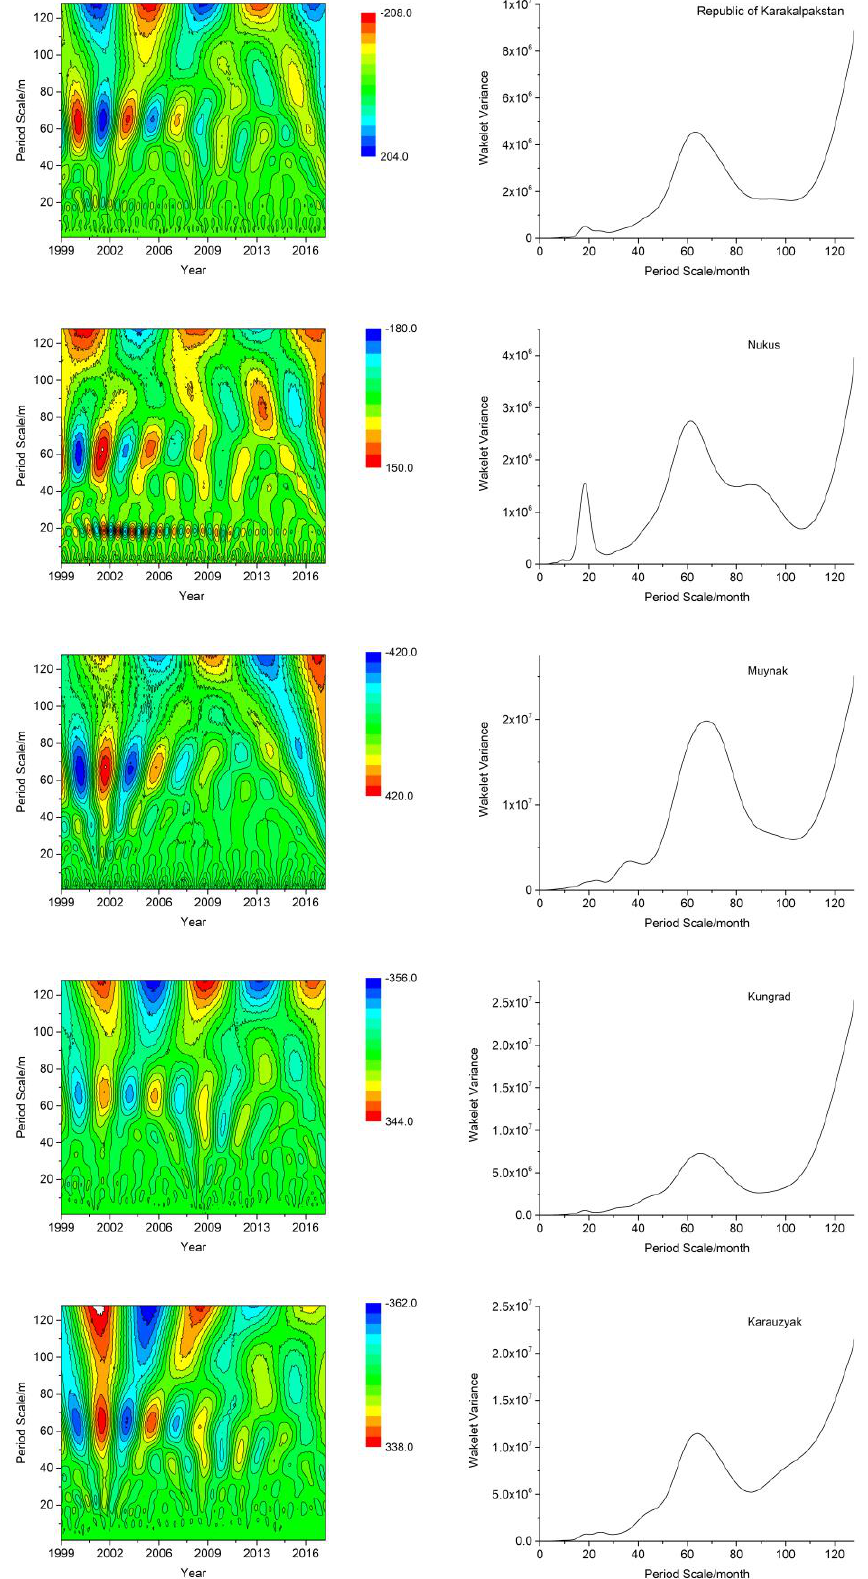
Figure 8. Monthly average groundwater level wavelet coefficient real part contour figure and wavelet variance figure from 1999 to 2017.